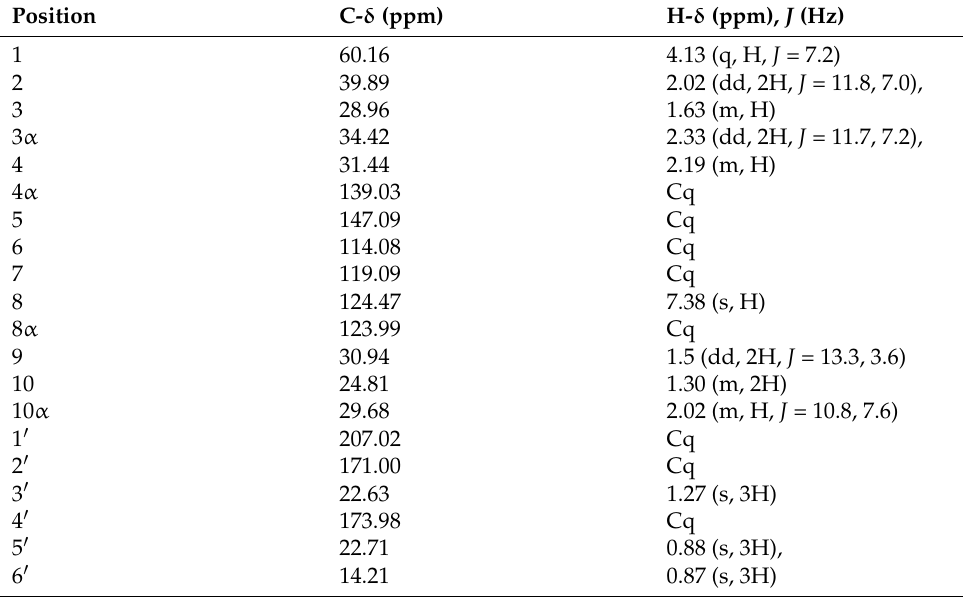
Table 2. The carbon-12 and proton (H-1) signals for